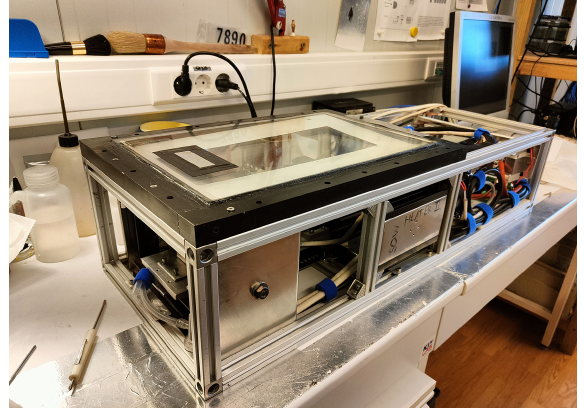
Figure 4. ICE-CAMERA out of the box. The focus target is fixed onto the DS.